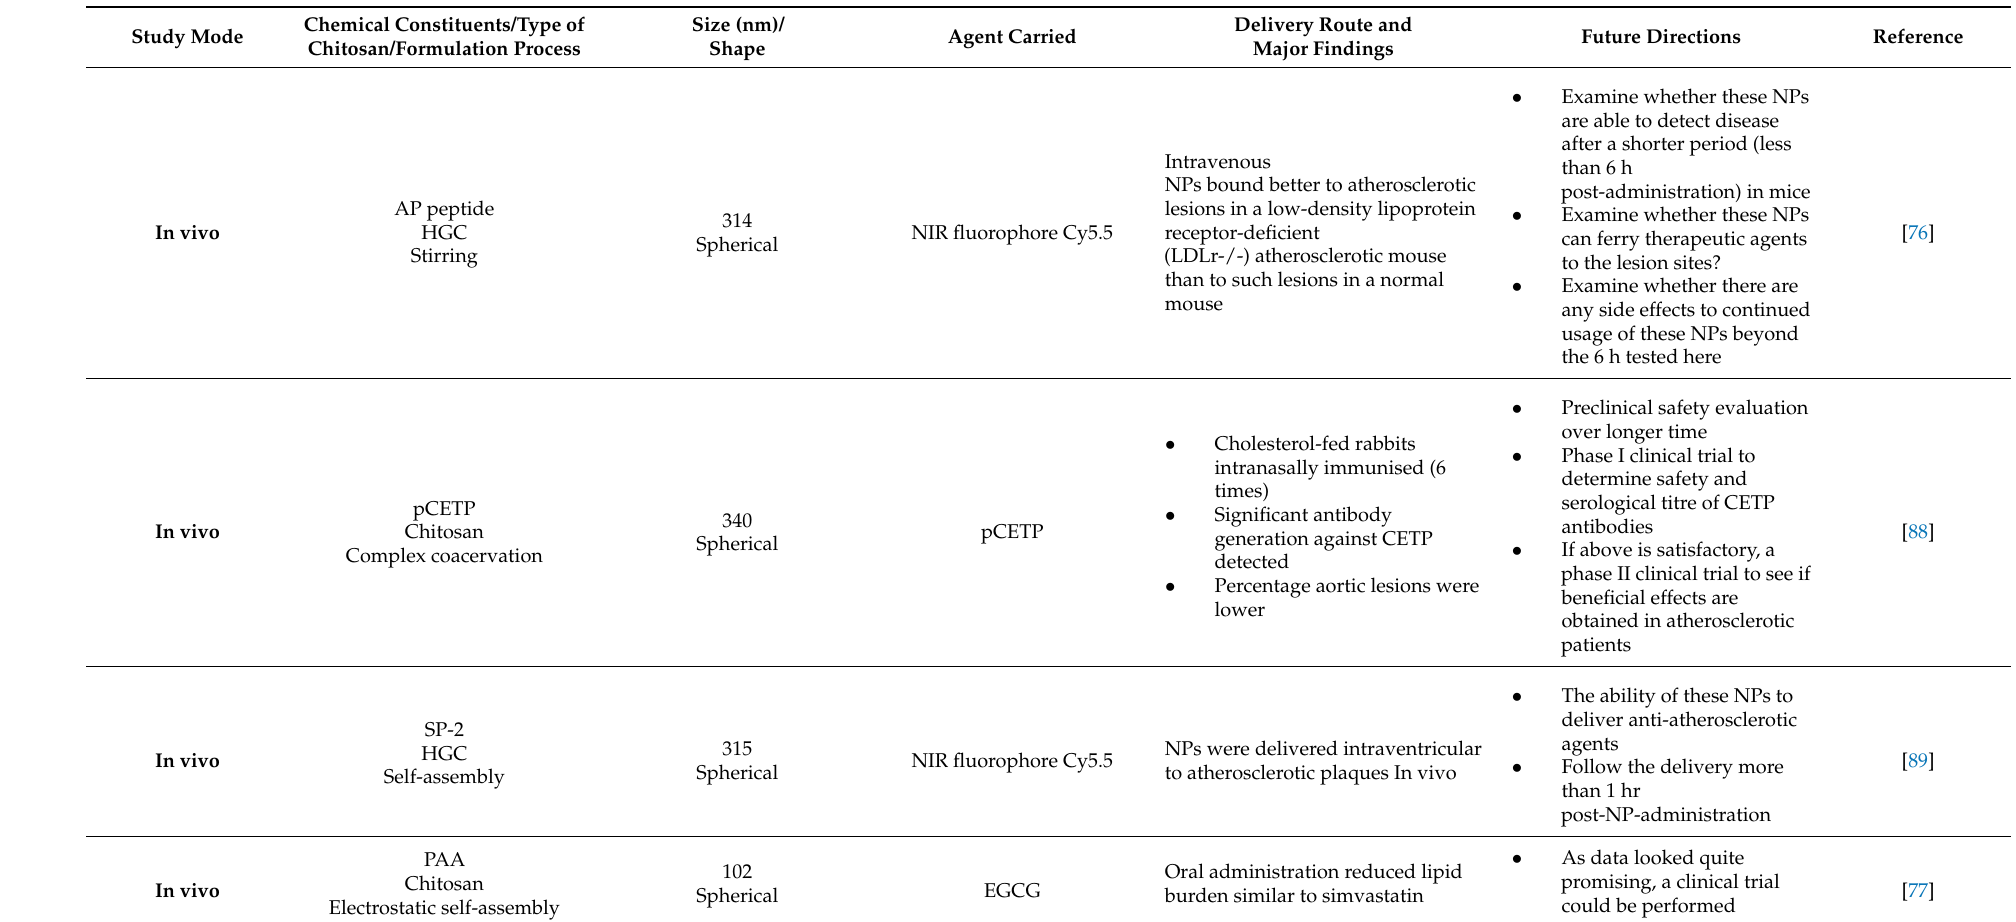
Table 2. Summary of studies using chitosan nanoparticles In vivo in atherosclerosis